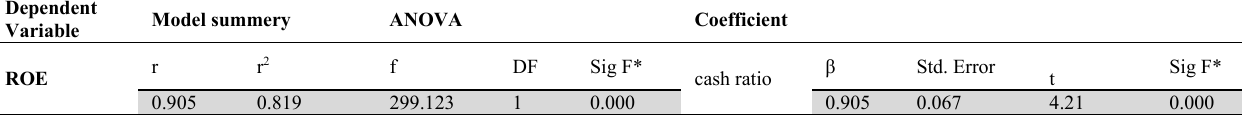
Simple regression test results, the effect of cash ratios at return on equity Dependent